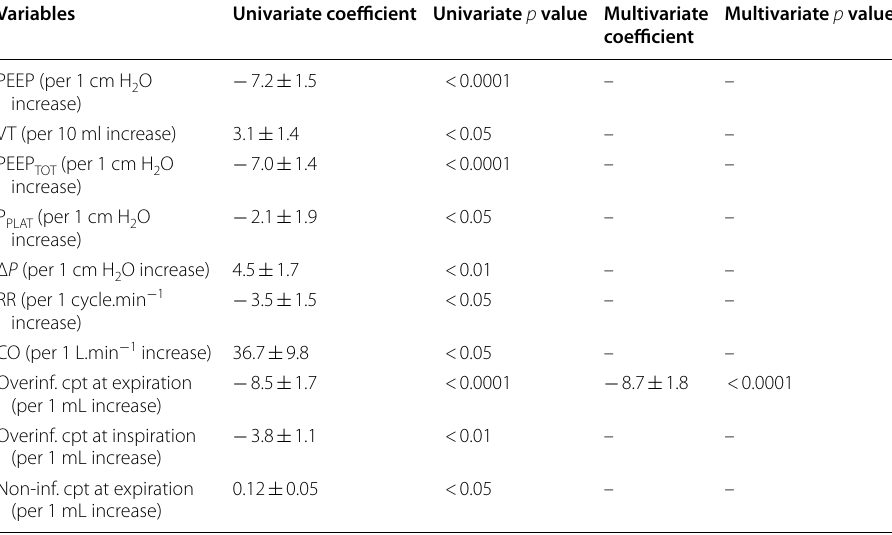
Bias between methods was computed as EELV MBNW minus EELV CT . PEEP and Δ P were not included in the multivariate model for collinearity with PEEP TOT CO cardiac output; ∆P driving pressure EELV CT end‑expiratory lung volume assessed with computed tomography; EELV MBNW end‑expiratory lung volume assessed with the multiple breaths N 2 washin–washout technique; non-inf. cpt non‑inflated compartment on CT; overinf. cpt. overinflated compartment on CT; PEEP positive end‑expiratory pressure; PEEP TOT total positive end‑expiratory pressure; P PLAT plateau pressure; RR respiratory rate; VT tidal